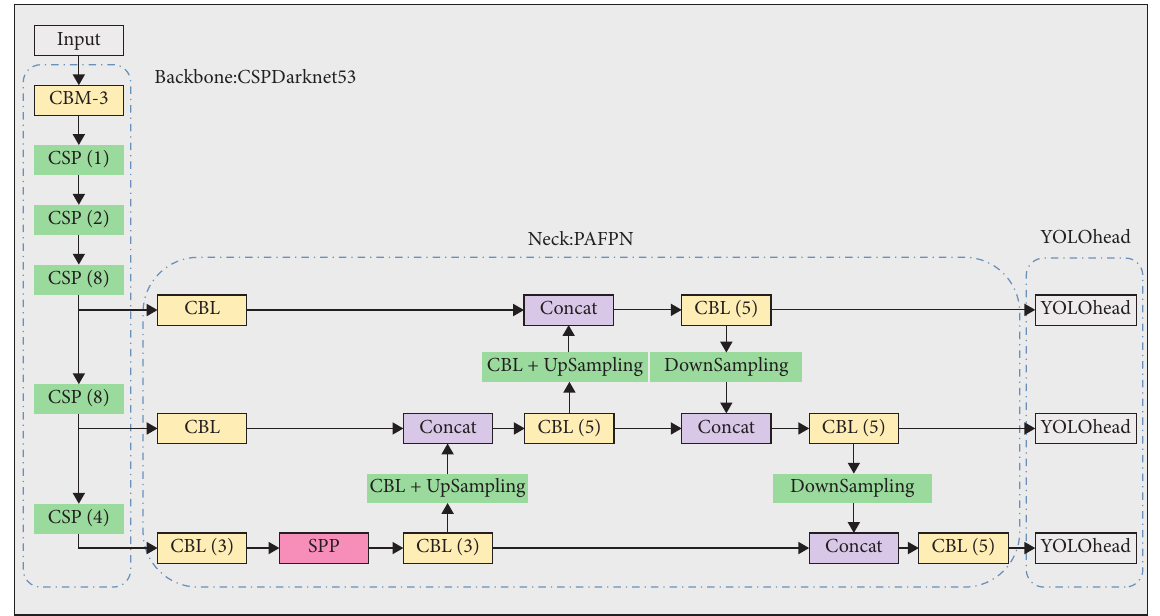
Figure 1: Schematic diagram of YOLO-V4 model